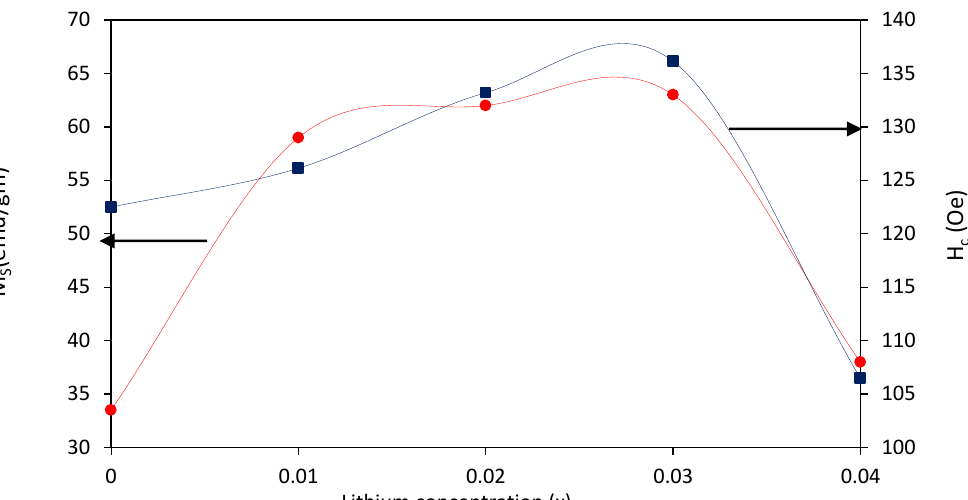
Fig. 11: Change of saturation magnetization and coercivity with Li ions